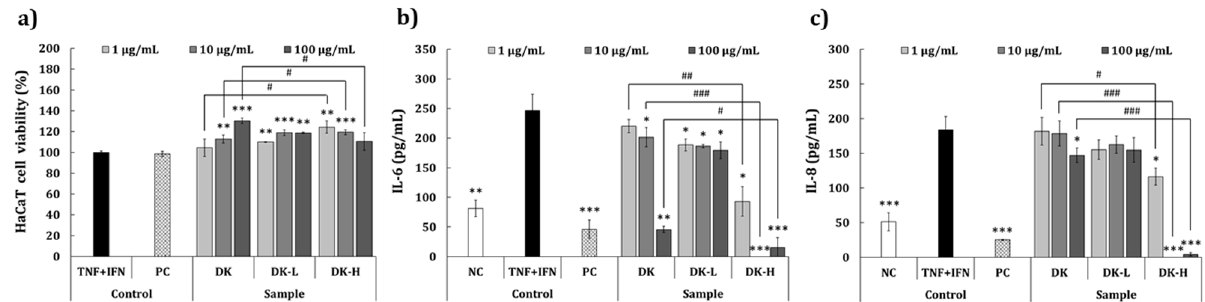
Figure 3. Effects of the fractions isolated from persimmon fruit on the ( a ) viability of HaCaT cells and inhibition of ( b ) interleukin-6 and ( c ) interleukin-8 in TNF- α and IFN- γ -induced HaCaT cells. Culture medium and TNF- α + IFN- γ (each 10 ng/mL) were used as a negative control (NC) and skin inflammation-induced control, respectively. Treatment with dexamethasone (20 μ g/mL) followed by TNF + IFN stimulation of the cells was used as a positive control (PC). DK, DK-L, and DK-H refer to D. kaki extract and its low- and high-molecular-weight fractions, respectively. Statistical differences between the groups were analyzed by Student’s t -test. The asterisks indicate significant differences between each sample and LPS-treated control. The crosshatch patterns indicate significant differences between DK and DK-H at the same concentrations. * and #, p < 0.05; ** and ##, p < 0.01; *** and ###, p < 0.001.